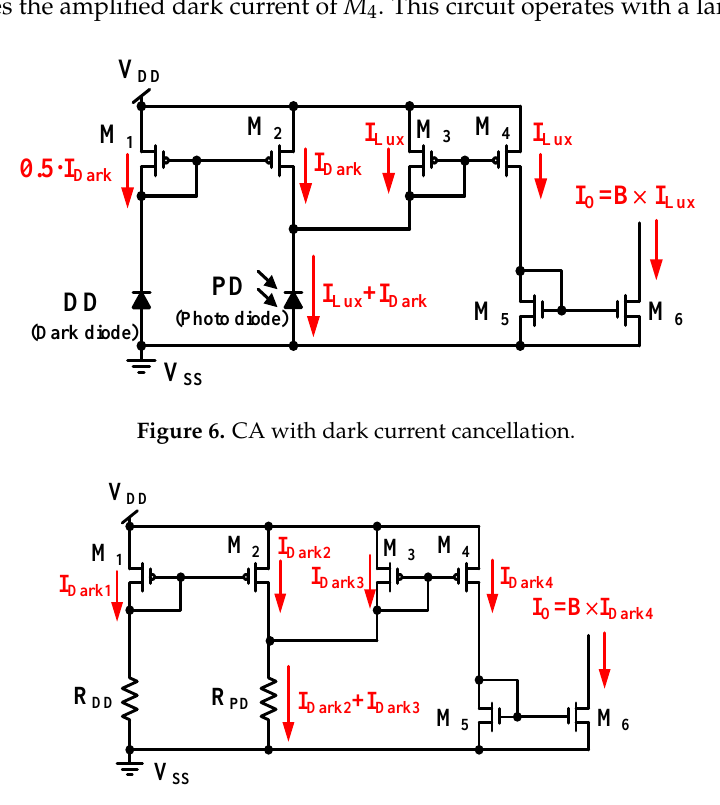
Figure 7. All dark currents of MOSFETs in Figure 6 in dark conditions.